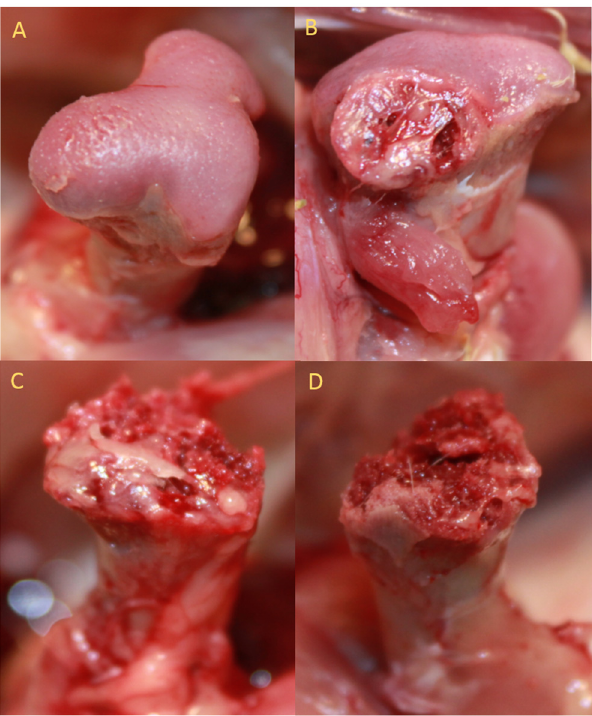
Fig 1. Representative BCO lesions for proximal femora. Severity of the lesions are scored by macroscopic examination: Femoral Head Separation, FHS (Panel A), Femoral Head Transitional degeneration, FHT (Panel B), Femoral Head Necrosis, FHN (Panels C and D) [1].